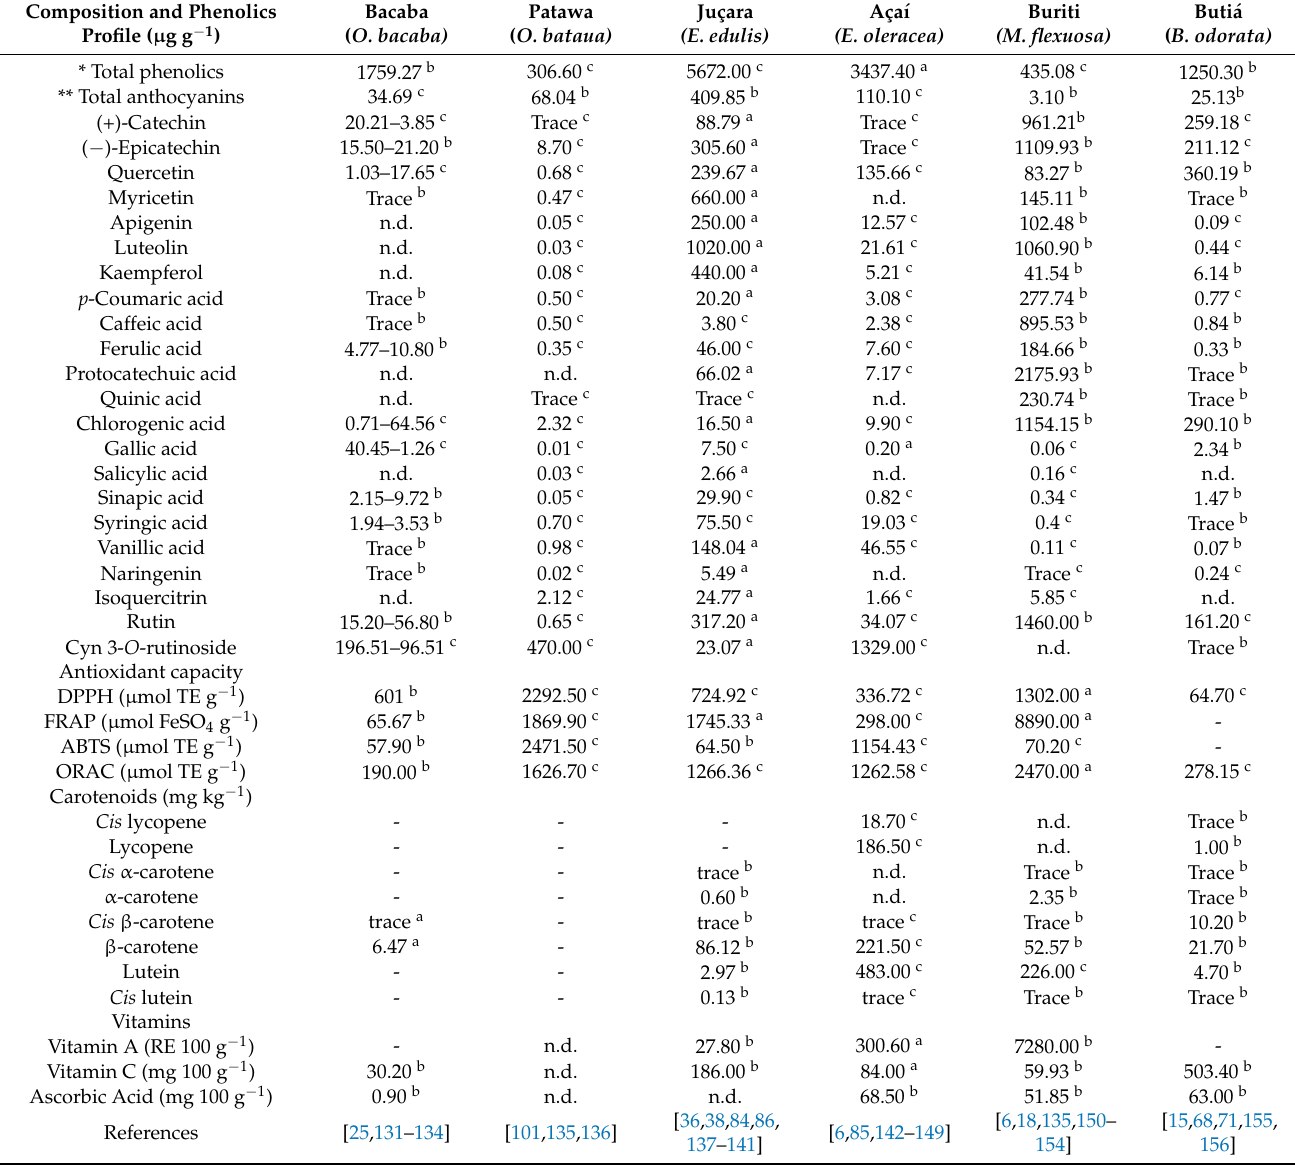
Table 4. Bioactive compounds and antioxidant activity of extracts from fruits of the Arecaceae